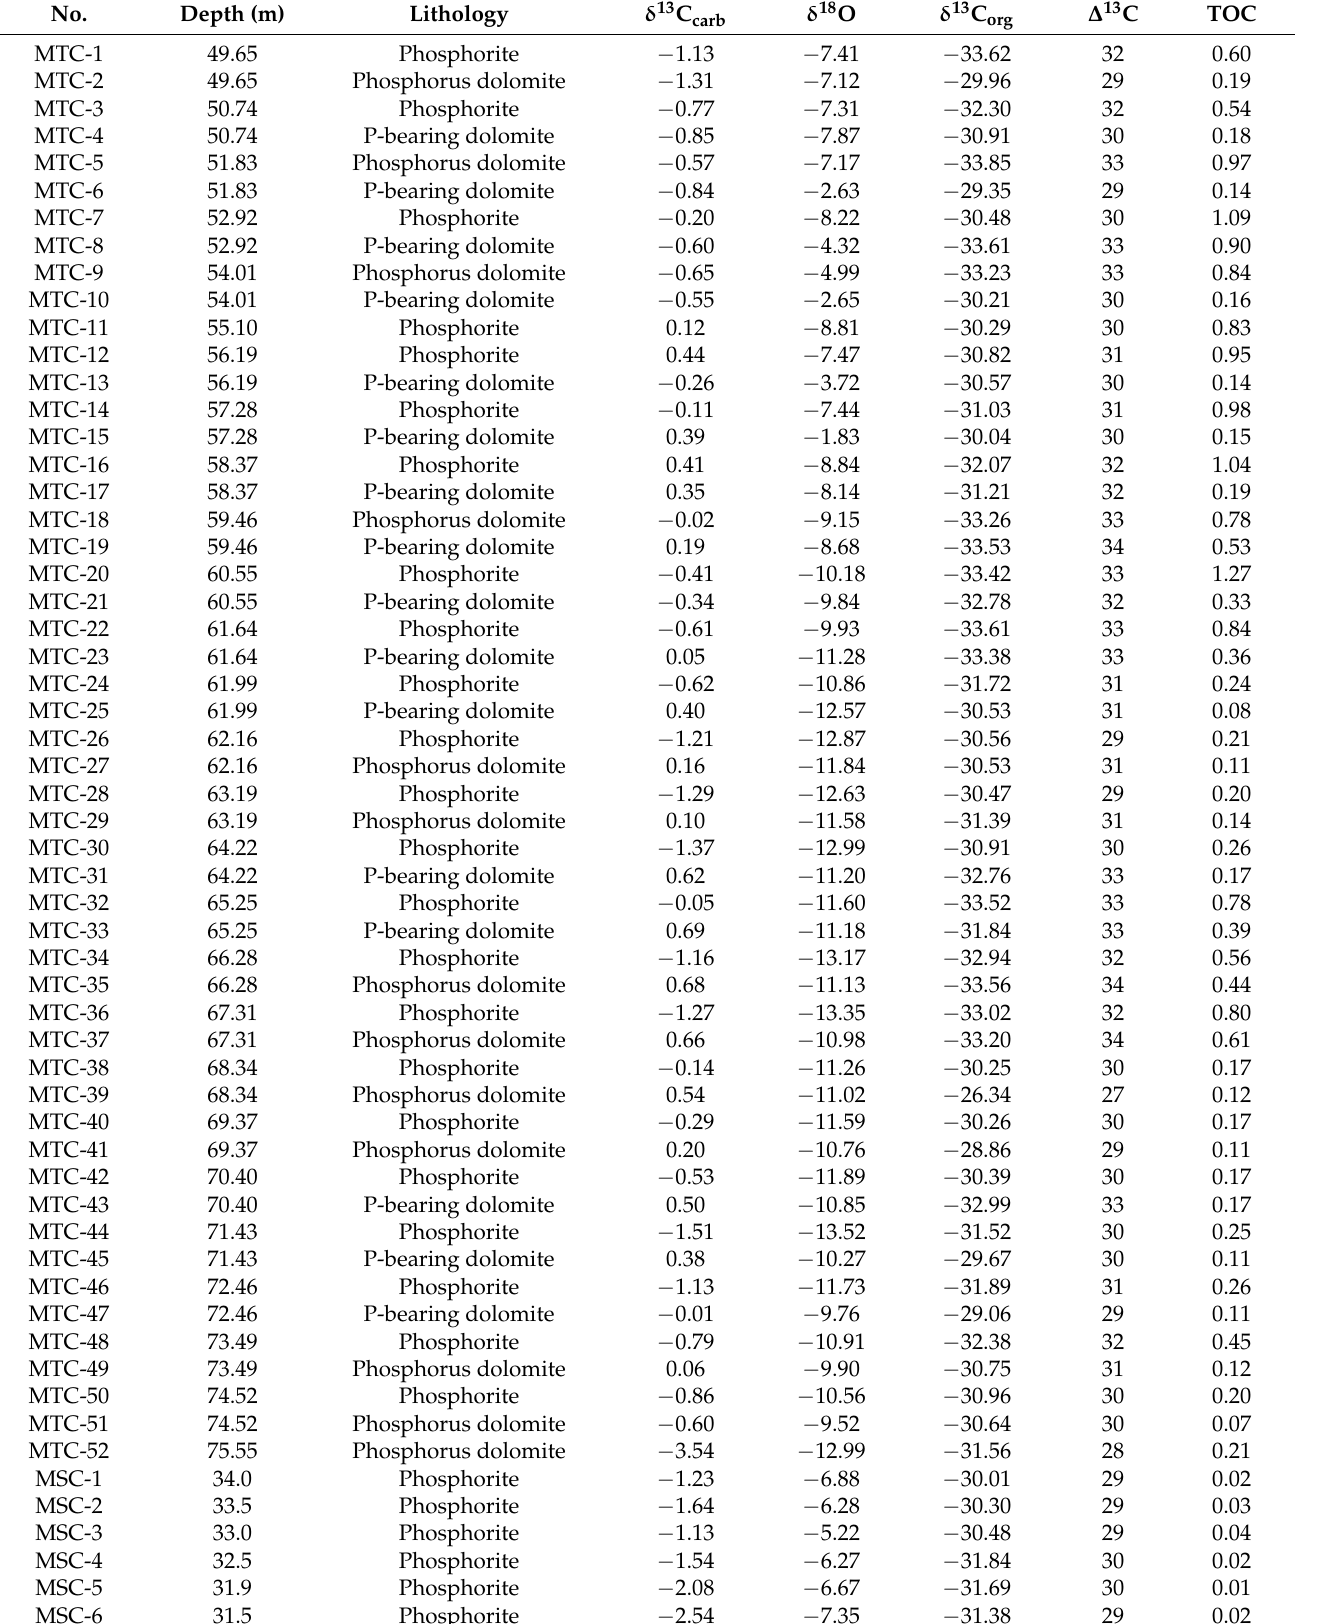
Table 1. Concentrations of C-O isotopes (‰) and concentrations of TOC (wt.‰) of phosphorus rock series from the Zhijin and Meishucun (MSC) areas, wherein MSC data were from